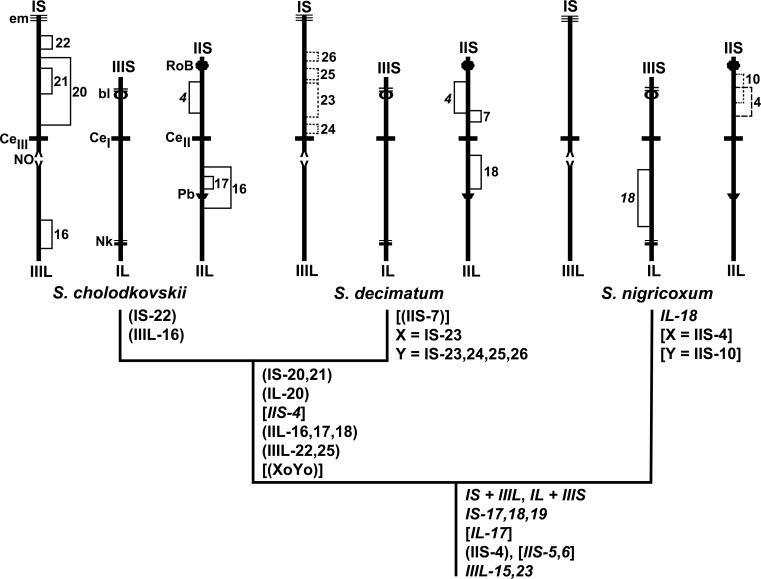
Cytophylogeny of the Simulium cholodkovskii lineage, with terminals depicted by idiograms of each species.The outgroups (S. erythrocephalum and S. vittatum) are not shown on the cladogram. Rearrangements are shown in italics if fixed synapomorphies, in parentheses if polymorphic synapomorphies, and in square brackets if shared characters that could not be determined as plesiomorphic or synapomorphic. The homologues of each chromosome (I, II, III) are shown as tightly synapsed, and the arms are indicated as long (L) or short (S). Only diagnostic inversions (frequency > 0.10) for each species are shown on the idiograms. Fixed inversions are bracketed on the left. Polymorphic inversions are bracketed on the right as solid lines if autosomal, dashed if X-linked, and dotted if Y-linked. Landmarks are labeled on the idiogram for S. cholodkovskii: bl = blister with 2 heavy bands, Ce = centric region (with subscript indicating chromosome I, II, or III), em = end marker, Nk = neck, NO = nucleolar organizer, Pb = parabalbiani, RoB = ring of Balbiani.